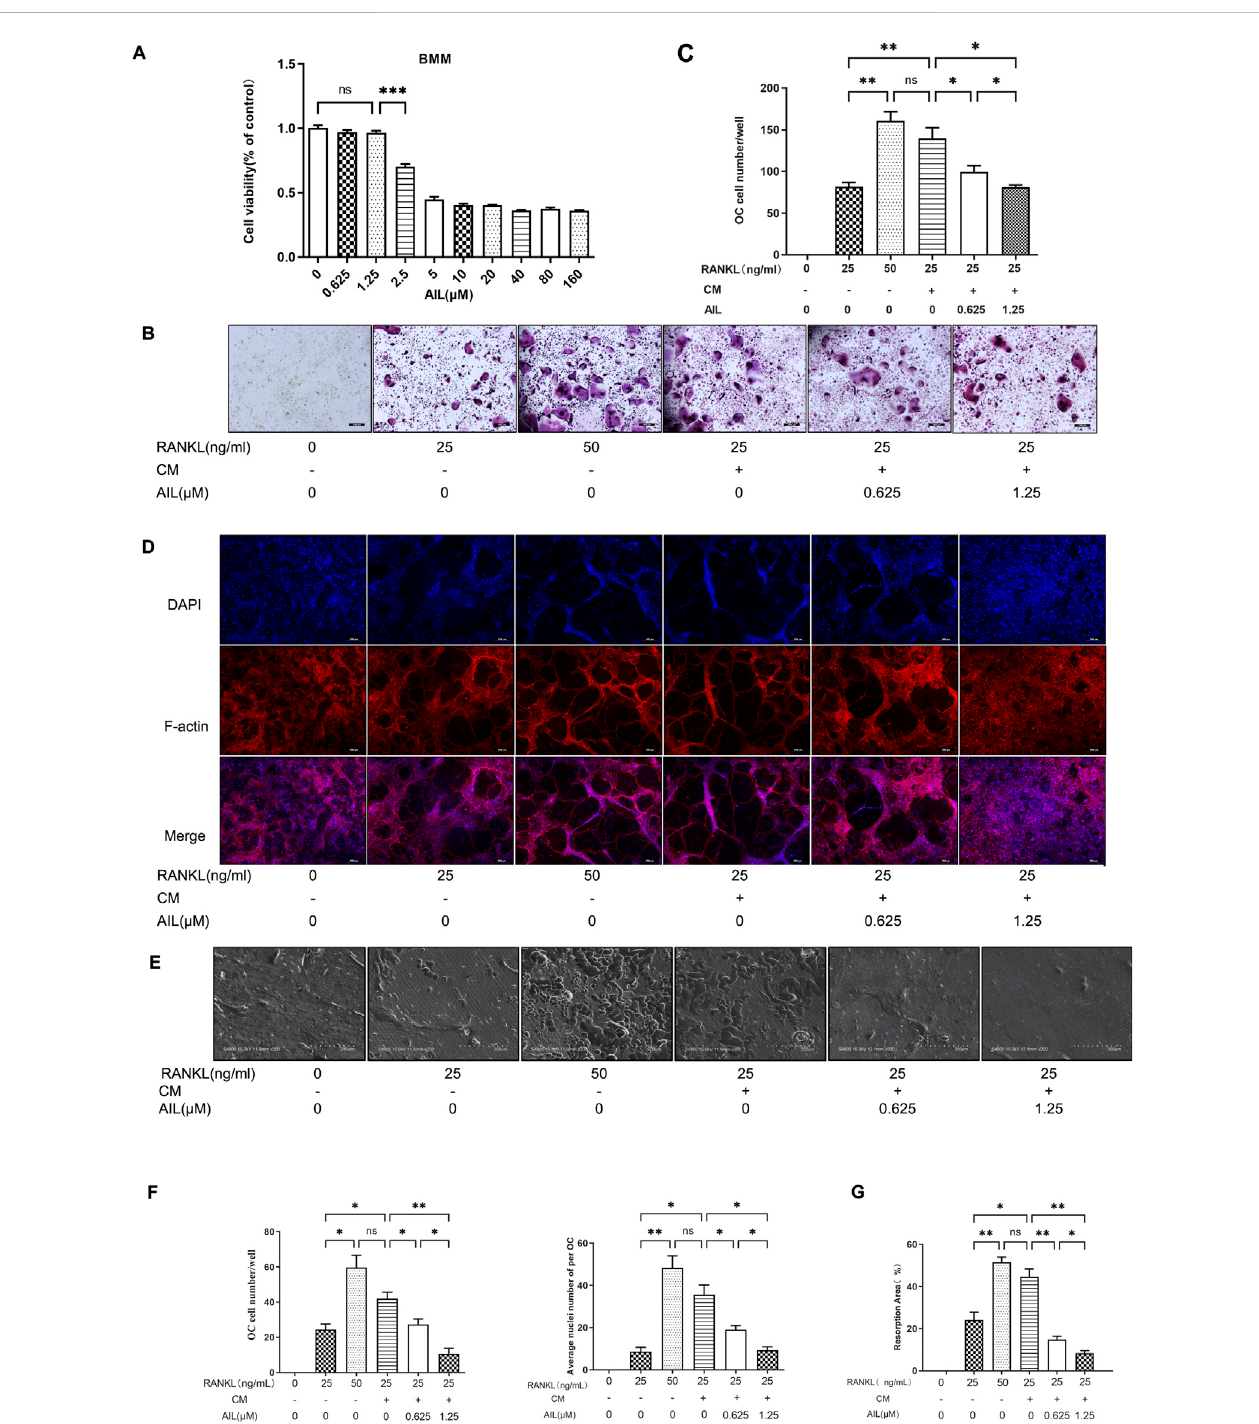
The supernatant of MDA-MB-231 cells can increase the osteoclast differentiation induced by RANKL, and non-toxic concentration AIL can block the osteoclastdifferentiationanditsfunctionsimultaneouslyinducedbyRANKLandMDA-MB-231CM invitro . (A) CytotoxicityofBMMcellsafter48 hofexposure to variousAIL concentrations. (B,C) Different RANKL concentrations (25or 50 ng/ml) wereused to generate TRAP staining images (50 × magni fi cation) ofthe BMM cells and quantitative results of TRAP-positive multinuclear cells were determined. The MDA-MB-231CM were treated using varying AIL concentrations. (D,F) An image (200 × magni fi cation) of actin ring formation, induced by varying concentrations of RANKL (25 ng/ml or 50 ng/ml) and MDA- MB-231CM treated with differing AILconcentrations, was obtained using immuno fl uorescence in combination with intranuclear DAPI staining. Both the total no. Of osteoclasts and average no. Of nuclei in each osteoclast were determined. (E,G) AIL treatment at various dosages decreased bone absorption in the BMM cells that were treated using MDA-MB-231CM and varying RANKL concentrations (25 or 50 ng/ml) (200 × magni fi cation). The ImageJ software was employed to calculate thearea ofboneabsorptionpitsintheabove image. The mean± SD ofthethree replicates wereused toexpressall thedata.* p < 0.05, ** p < 0.01, *** p < 0.001, in comparison to control